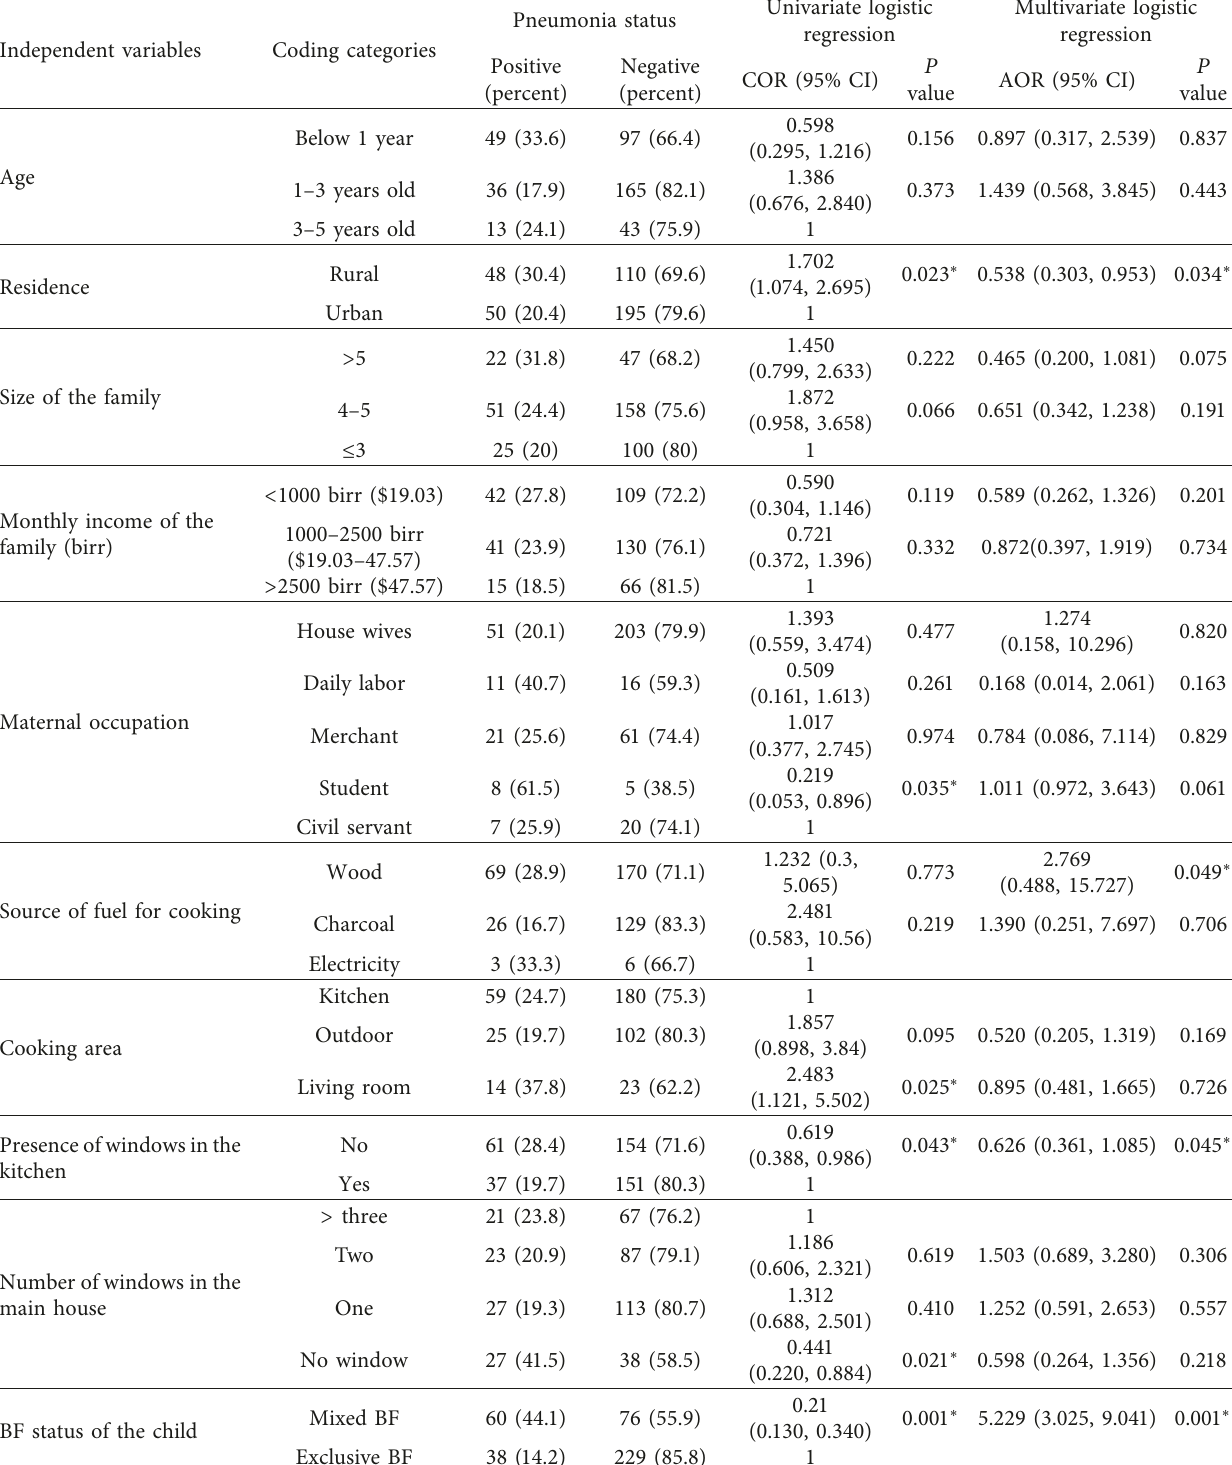
Table 3: Univariate and multivariate logistic regression analysis of potential risk factors associated with under-five pneumonia in Goncha Siso Enesie District, Northwest Ethiopia,